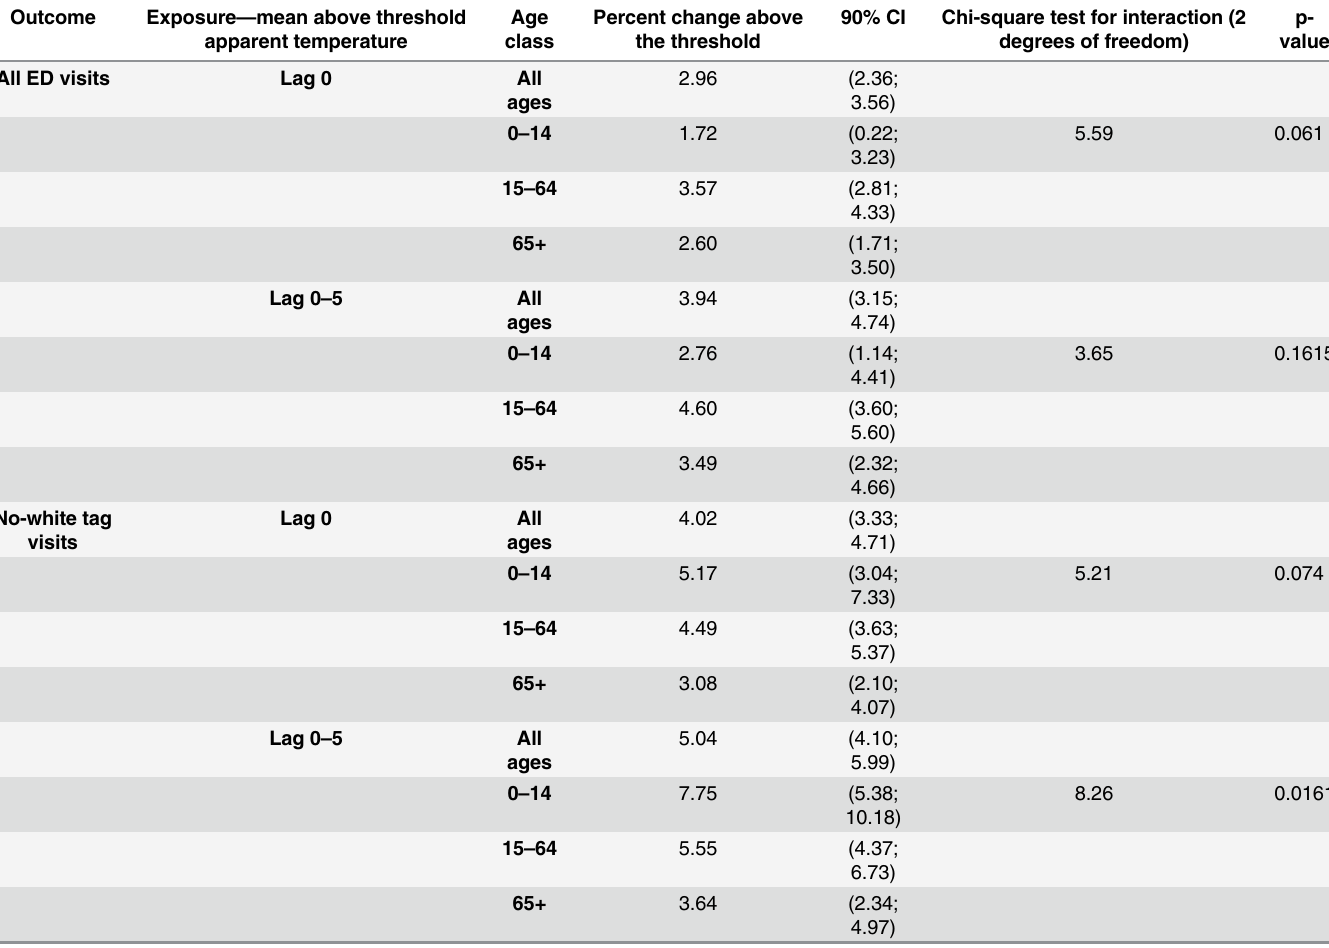
Table 2. Estimated effect of mean apparent temperature above the threshold on ED visits at lag 0 and lag 0 –